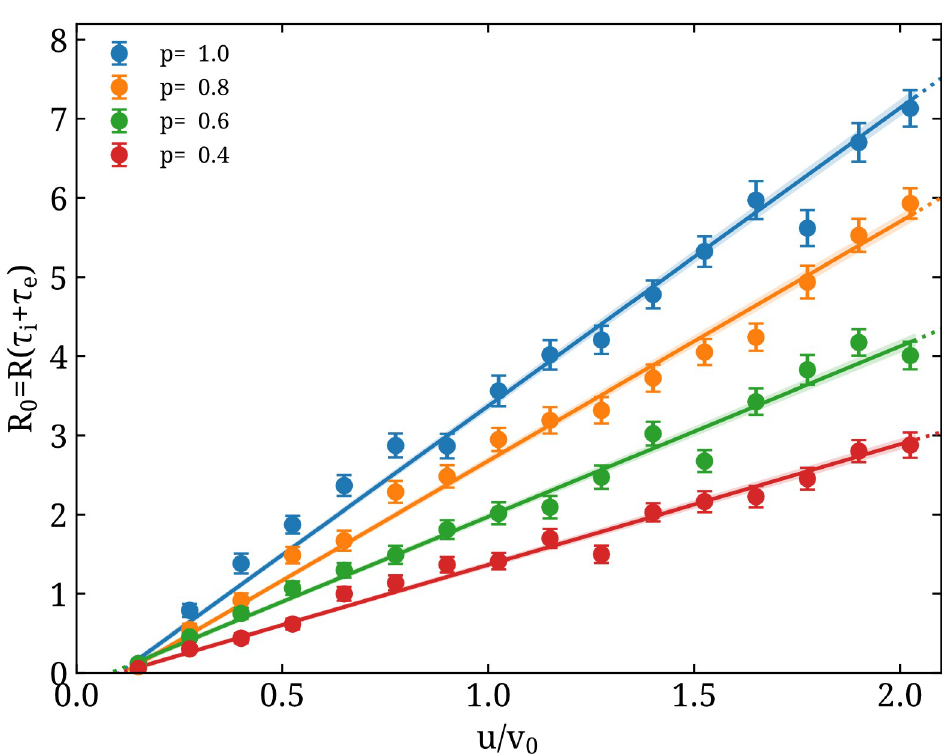
Fig 2. Particle model tuning. R 0 obtained as a function of the particle velocities u / v 0 for representative values of the probability of infection p .